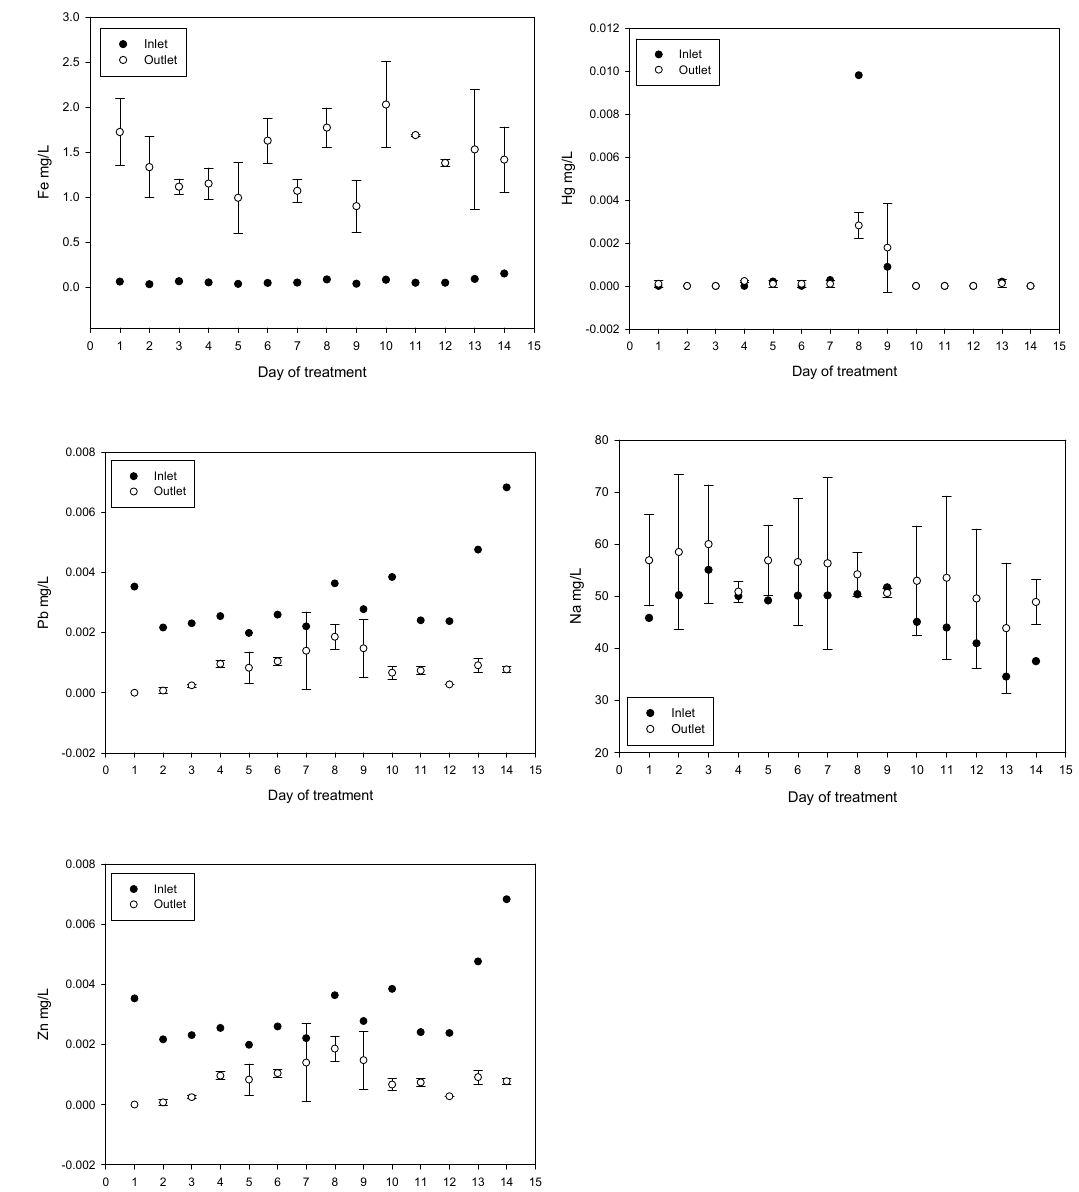
Figure 7. Metal and metalloid concentration variations (mean values with standard deviations).